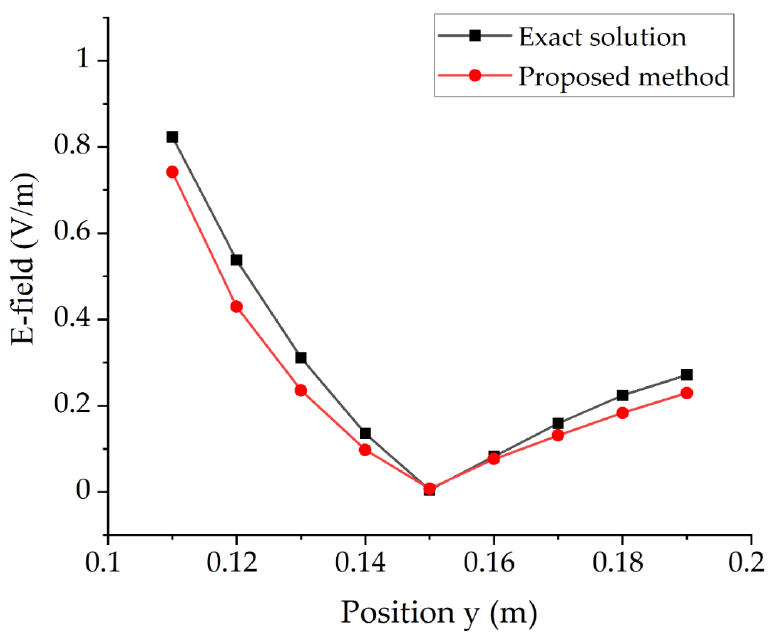
Figure 5. Comparison results of induced electric field by Hertzian magnetic dipole.